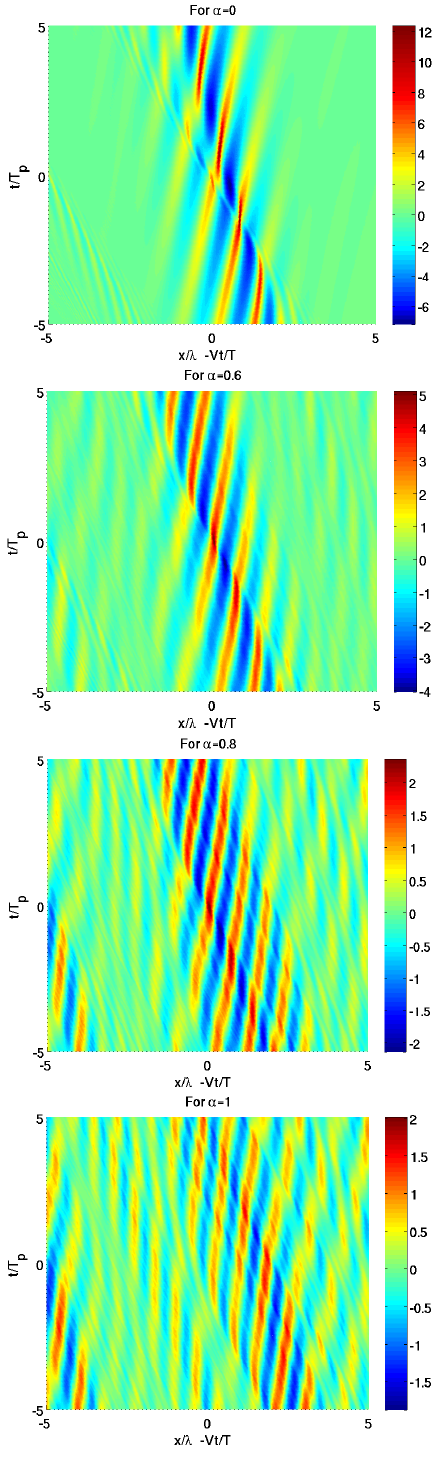
Fig. 7. Similar as Fig. 4 left column, but now for nonlinear evolution, the waves with Jonswap spectrum and restricted phase α( − π,π ] with α = 0 , 0 . 6 , 0 . 8 and